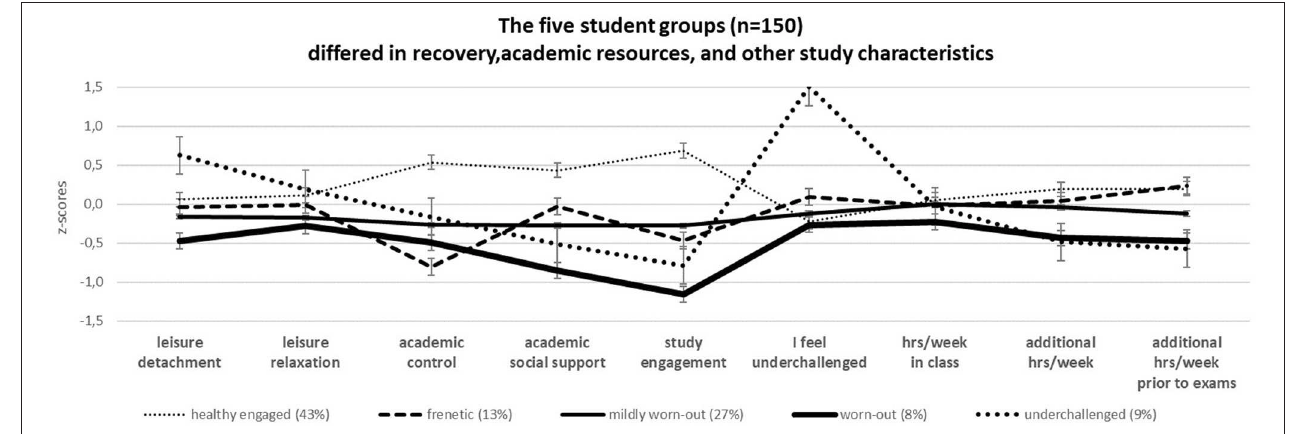
FIGURE 4 | Recovery, academic resources, and other study characteristics of the five BCSQ-12-SS classes in the stressed